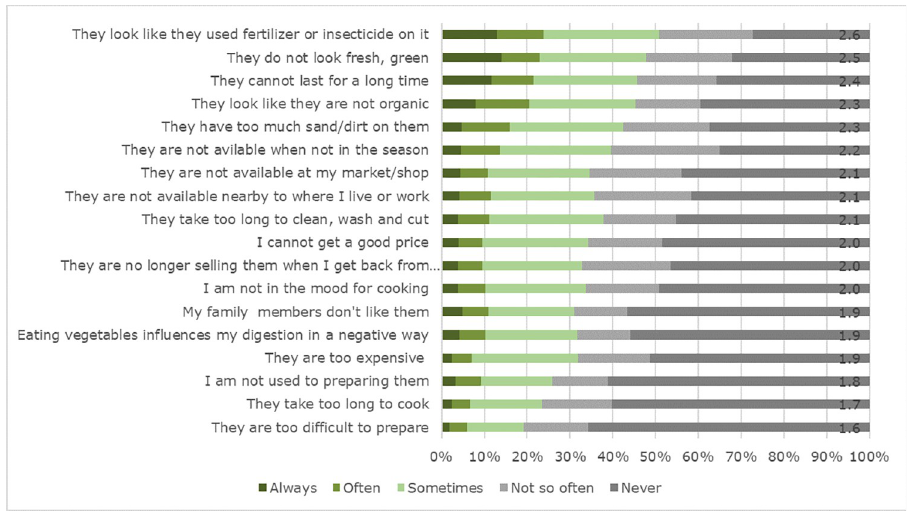
Fig 1. Reasons for abandoning buying GLV (N = 680, control period) in percentages and mean values added at the end of the